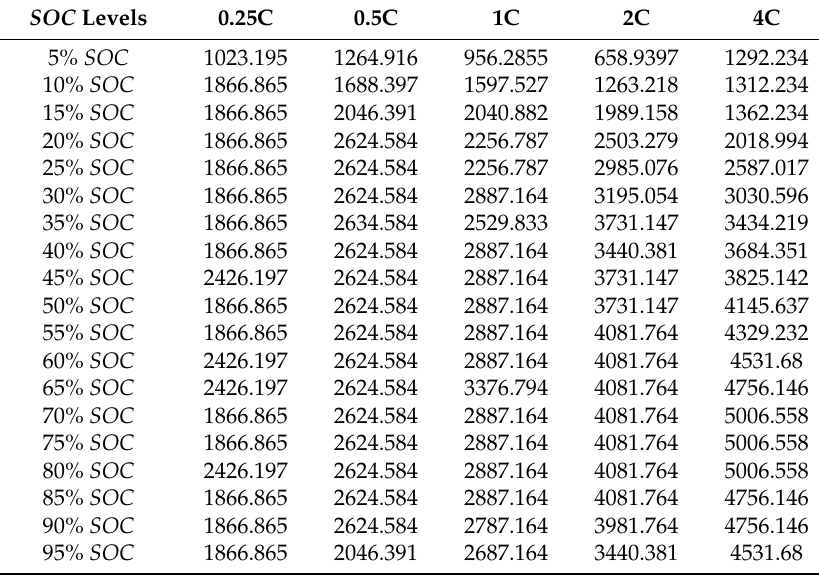
Table 7. 2-D lookup table for the determination of C 2